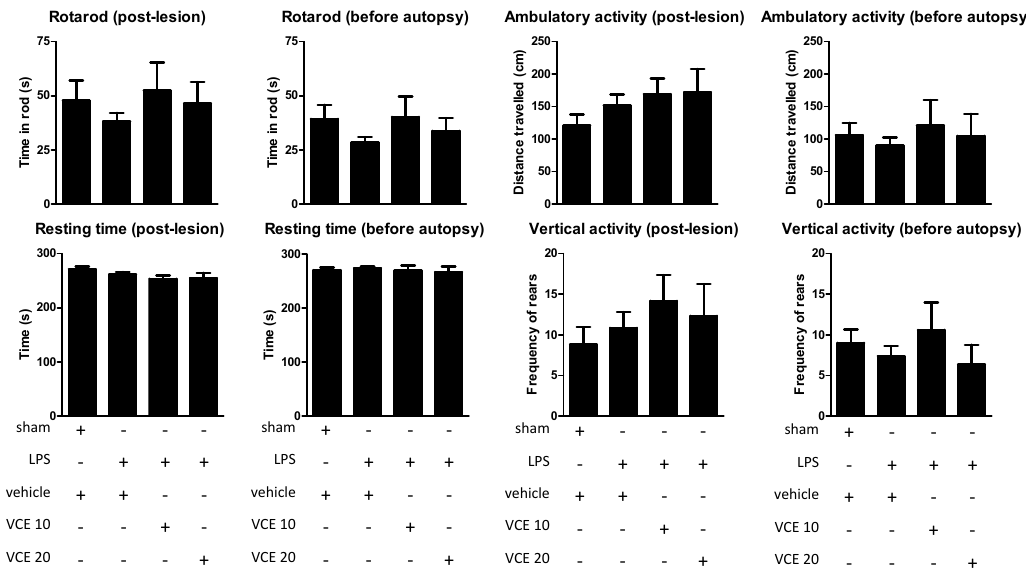
Figure 1. Rotarod performance, horizontal (ambulation) and vertical (rearing) activities, and resting time measured in a computer-aided actimeter in control and lipopolysaccharide (LPS)-lesioned mice orally treated for 28 days after lesion with vehicle (corn oil) or VCE-003.2 at the doses of 10 (VCE 10) or 20 (VCE 20) mg / kg. Data correspond to only one week after the onset of the treatment (post-lesion), or to only one day before the autopsy and after four weeks of treatment (before autopsy). Values are means ± SEM of more than six subjects per group. Data were assessed using the one-way analysis of variance followed by the Bonferroni test.